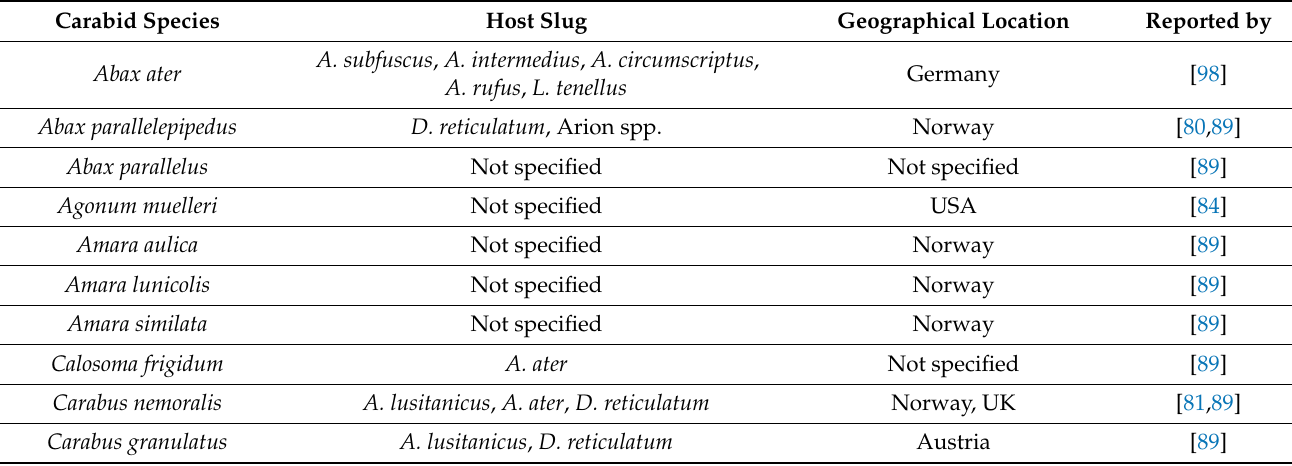
Table 3 lists different slug-controlling carabid species, along with the host slug species studied and the geographical locations in which the observations were made. Table 3. List of slug-controlling carabid